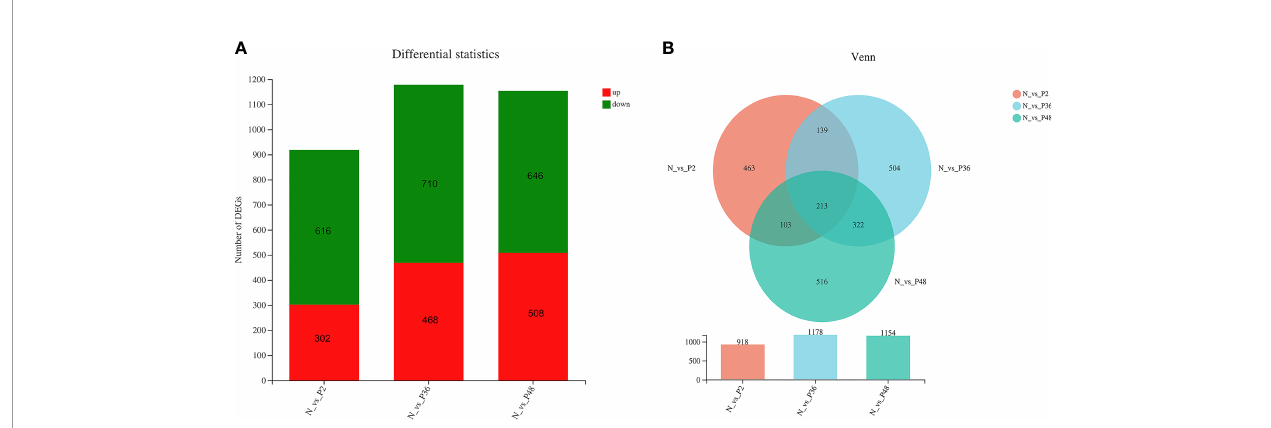
FIGURE 1 | Differentially expressed gene (DEG) analysis. (A) DEGs in N vs P2, N vs P36, and N vs P48. (B) Venn diagram of comparison